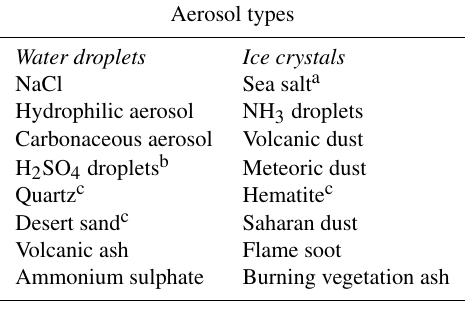
Table 1. List of the aerosols included in the σ -IASI-as